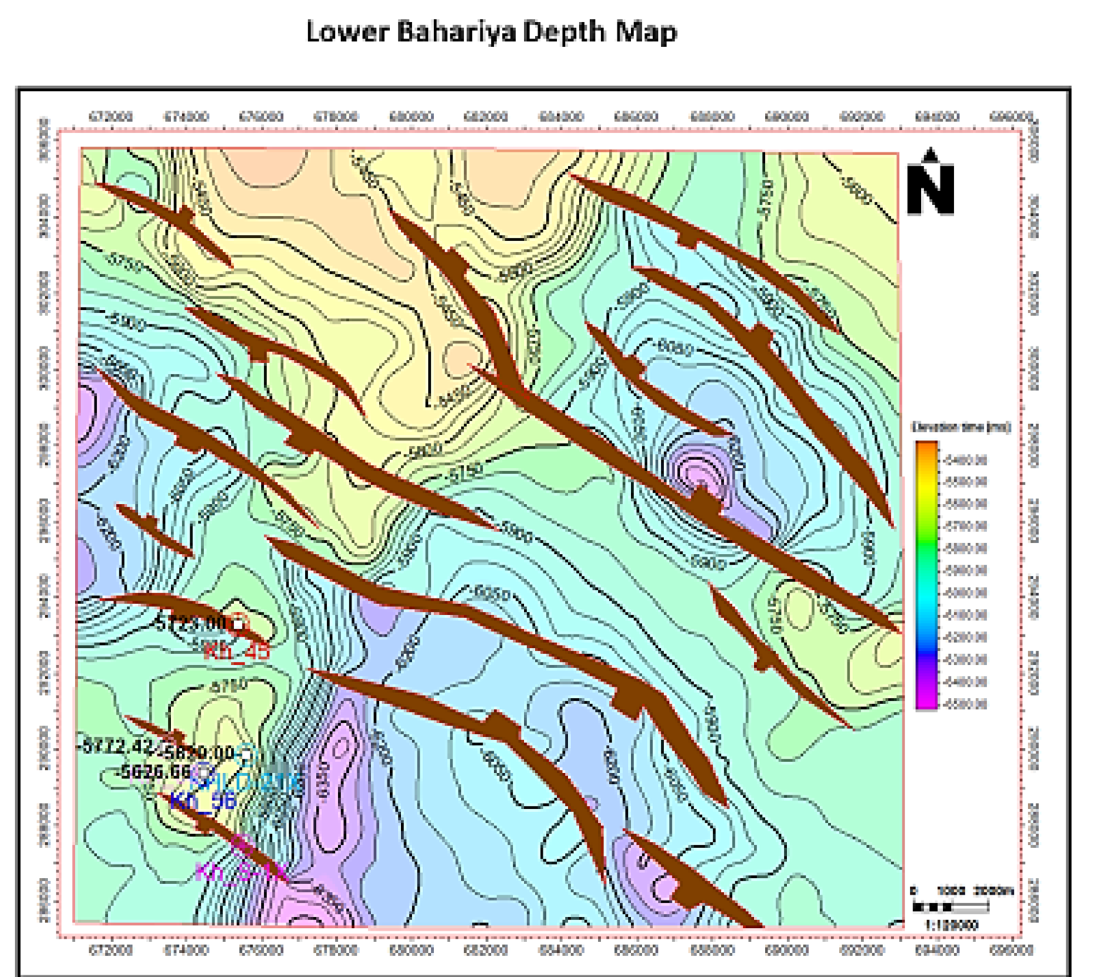
Fig. 16 Depth structure contour map on the top Lower Bahariya Formation in the study area (C.I = 100 ft)